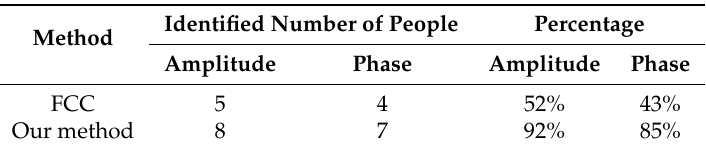
Table 1. Comparison FCC with our method amplitude or